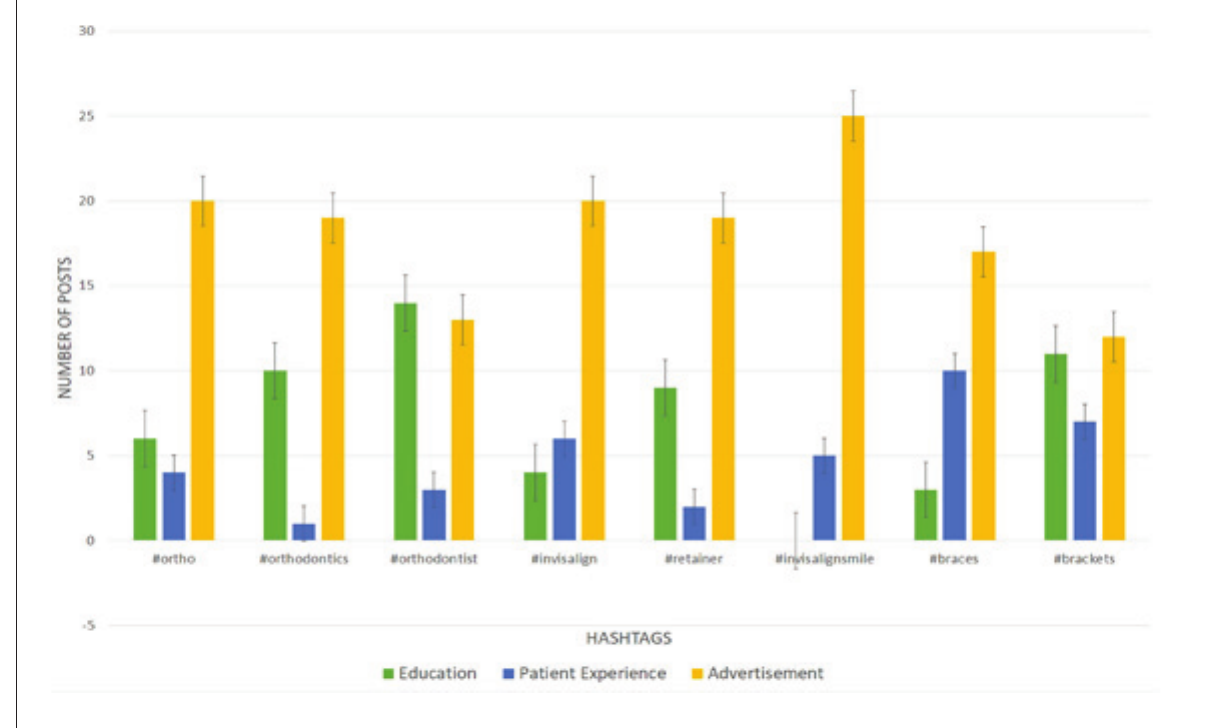
Figure 2. The distributions of the posts according to hashtag